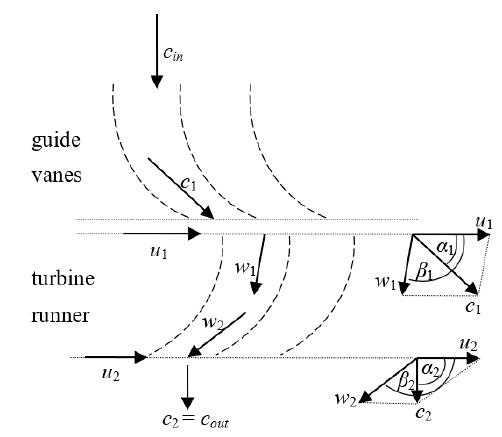
Figure 4. A velocity diagram of an axial-turbine.